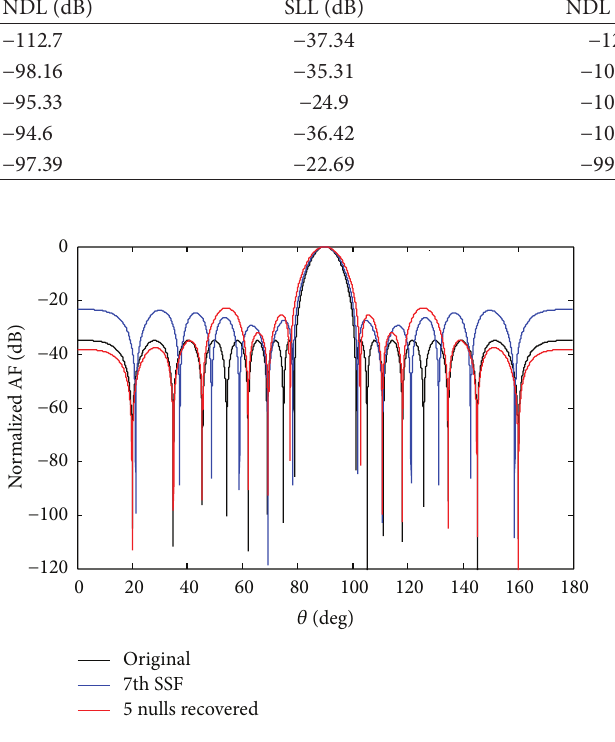
Figure 11: The original radiation pattern, the 𝑤 7 SSF, and recovery of five nulls.